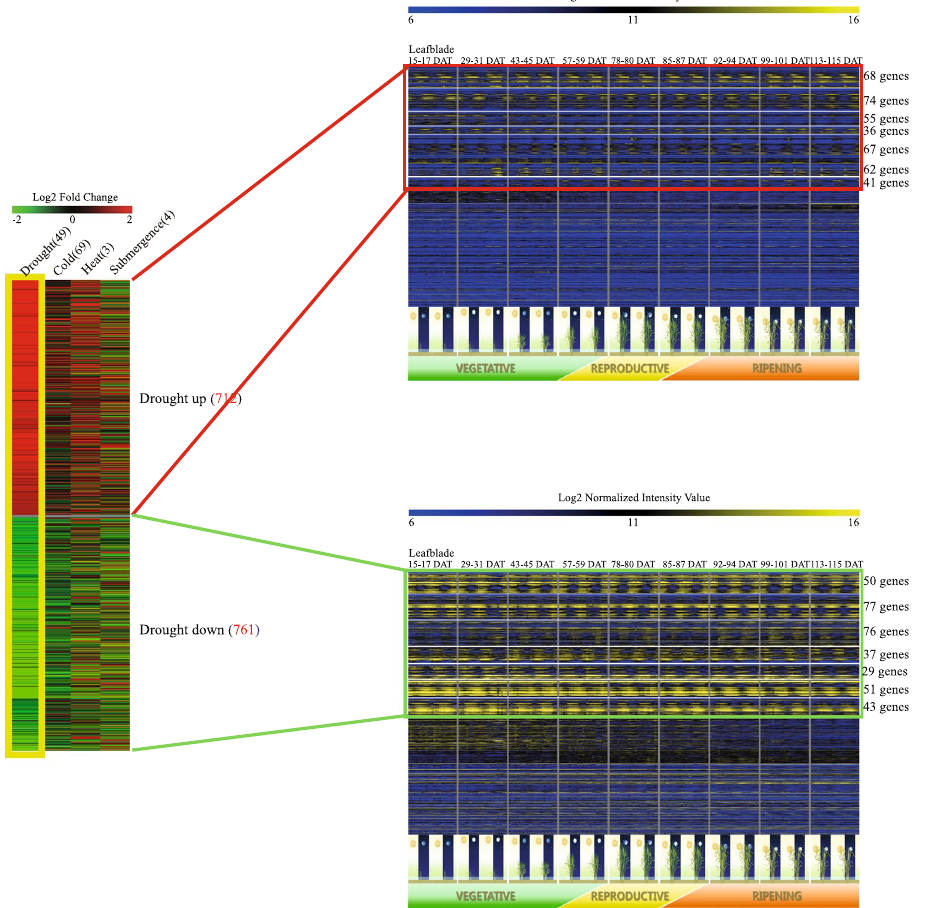
Figure 1. Identification and heatmap analysis of genes associated with both diurnal rhythm and drought response. Analysis (via KMC) of expression profiles for 766 genes with diurnal rhythm that are either up- regulated (403) or down-regulated (363) by drought. Average values for log 2 fold-changes under drought, cold, heat, or submergence conditions are shown in heatmap on left side. Drought-responsive genes are marked with yellow boxes. In two heatmaps on right side, log2-normalized intensity values indicate expression patterns for genes (red and green boxes) that were monitored at 2-h intervals (over 2-d period) using leaf blades from field- grown rice plants sampled during 9 developmental